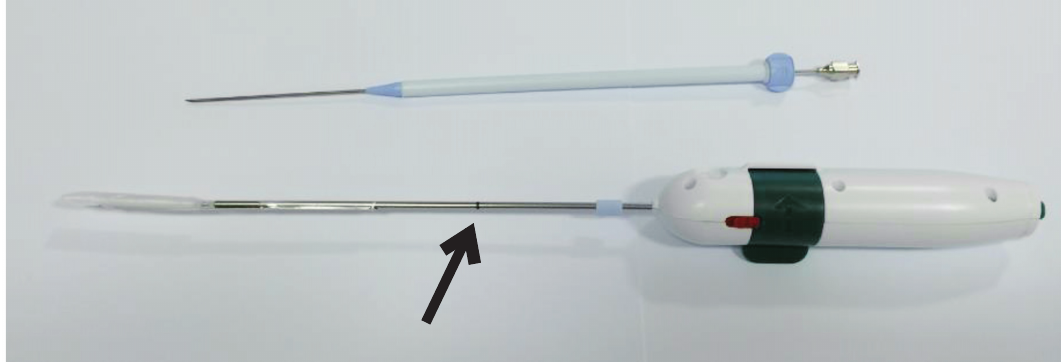
figure 3 - The RBI kit, with the needle with the dilatator (blue) and sheath (white) above, and the rectum balloon implant (rolled up) deployer (RBID) below. note the line on the RBID: when the RBID is inserted through the sheath up to this mark it means the tip of the deployer is at the end of the sheath. Retract the sheath while holding the RBID in